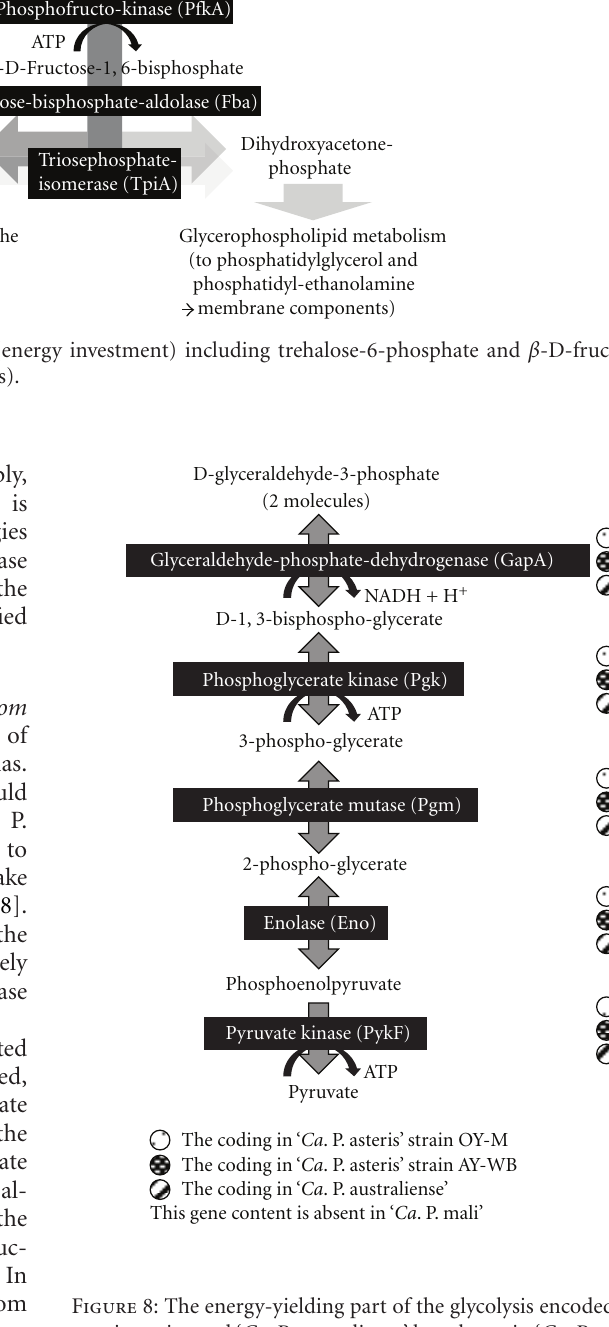
Figure 8: The energy-yielding part of the glycolysis encoded in the asteris strains and ‘ Ca . P. australiense’ but absent in ‘ Ca . P.